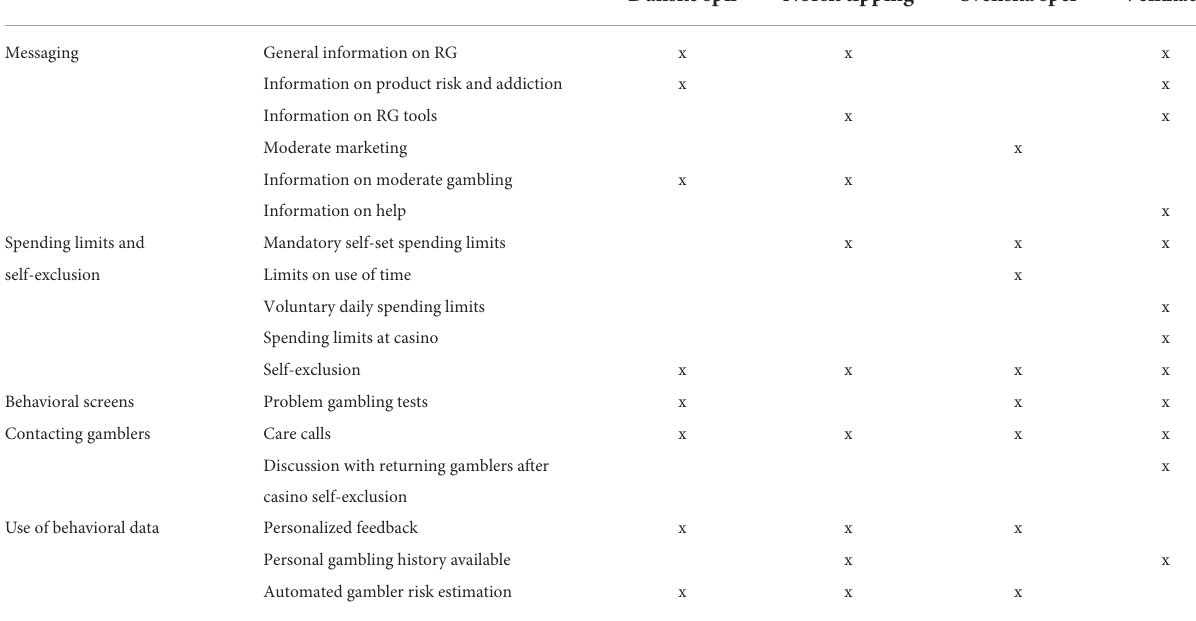
TABLE 1 Key responsible gambling (RG) practices of the Nordic state-owned gambling companies as reported in the annual